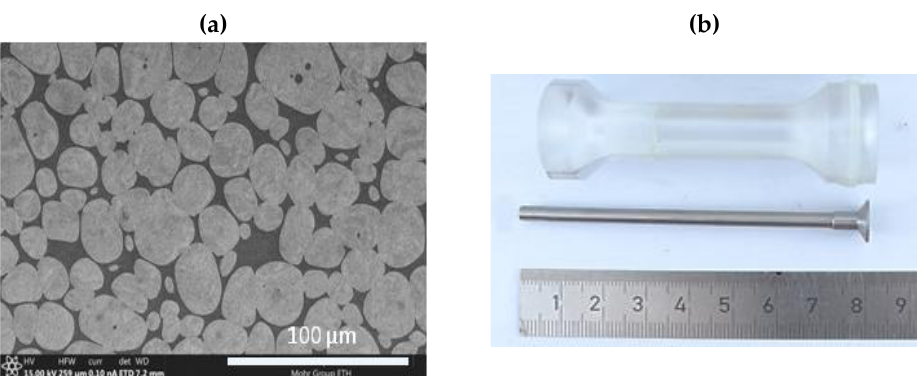
Figure 1. ( a ) Microstructure of the Y925 WHA alloy and ( b ) the down-scaled KE projectiles, here with the length to diameter ratio L/D = 20. Table 1. Same material parameters of the tested WHA grade.